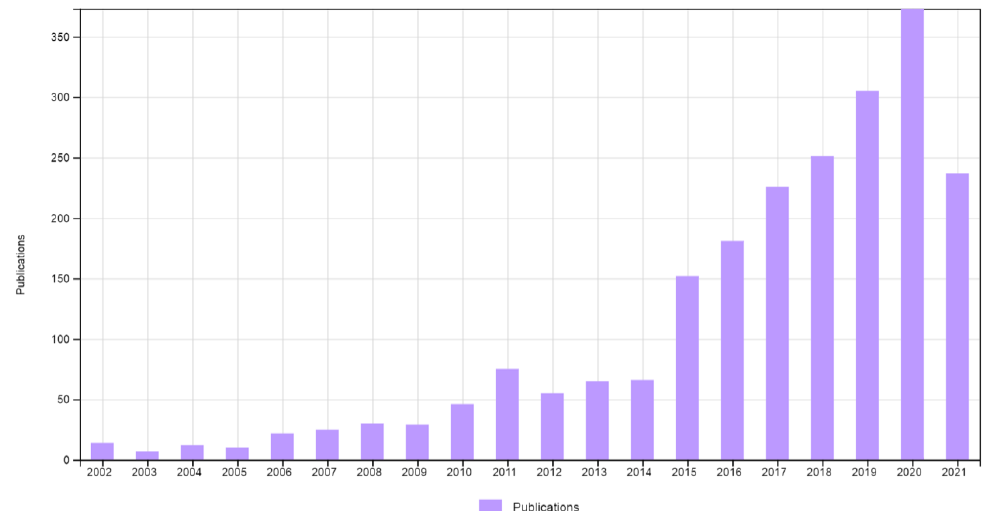
Figure 2. The annual publication of papers between the period 2002–2022 retrieved from WOS.